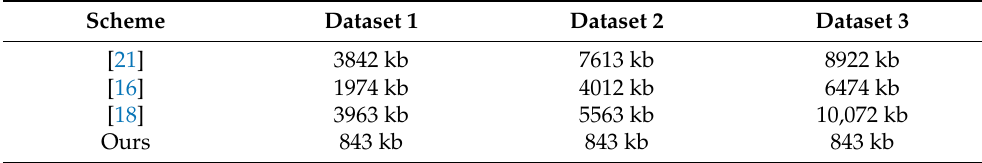
Table 5. Performance of each scheme under the effect of different